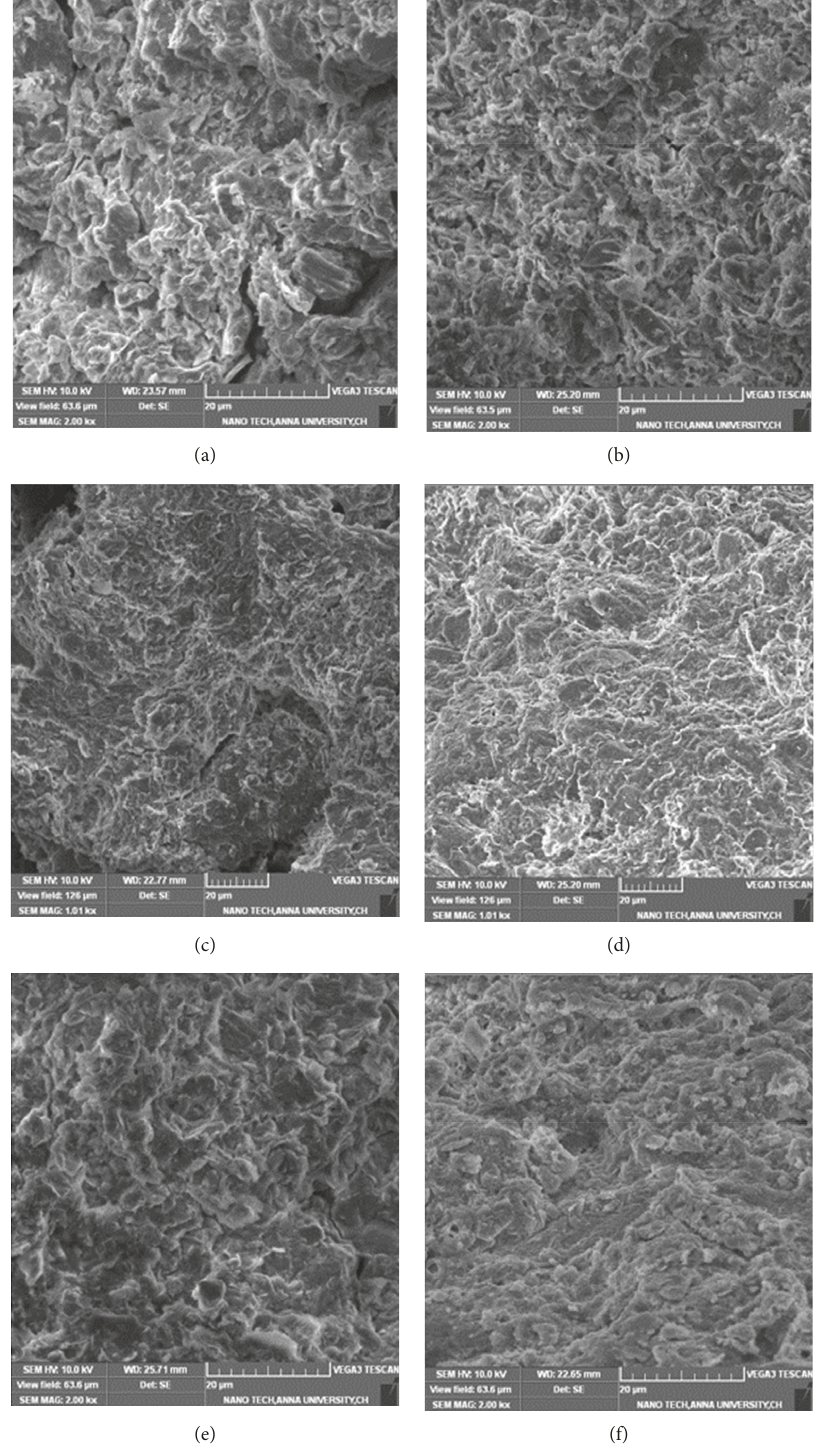
Figure 10: SEM micrographs of lime stabilized soil: (a) soil +3% lime; (b) soil+3% lime+0.25% BA; (c) soil+5.5% lime; (d) soil +5.5% lime+0.25% BA; (e) soil+7% lime; (f) soil+7% lime +0.5%